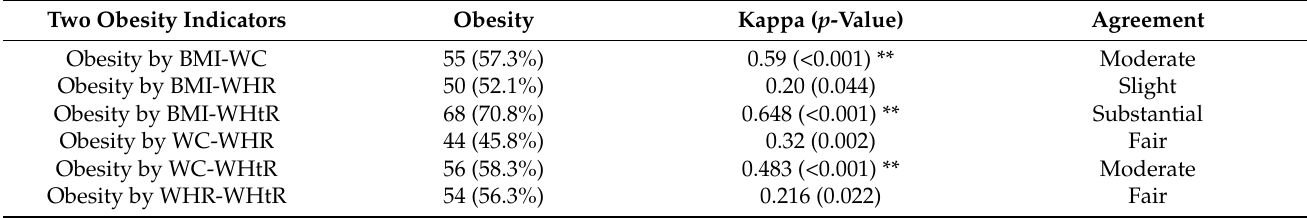
Table 4. Agreement among anthropometric markers for identifying obesity.